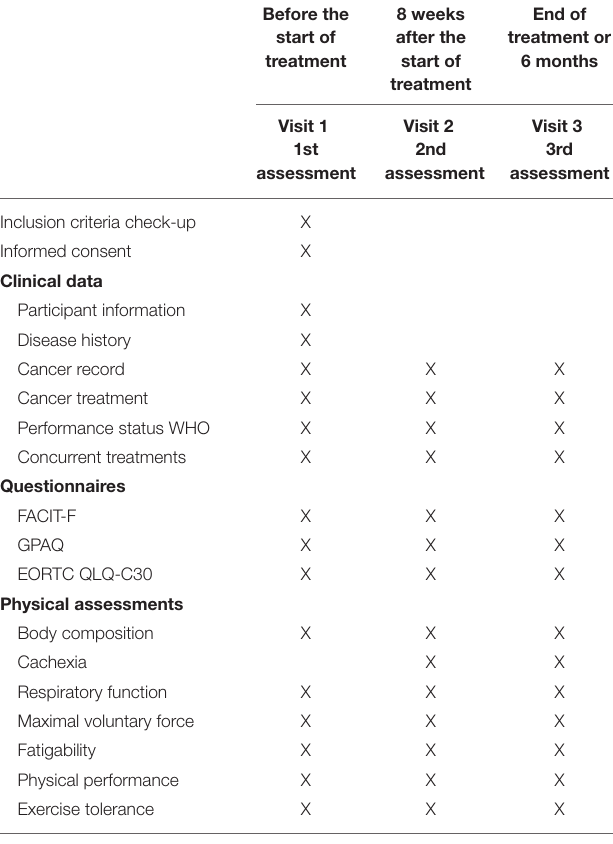
TABLE 2 | Study time